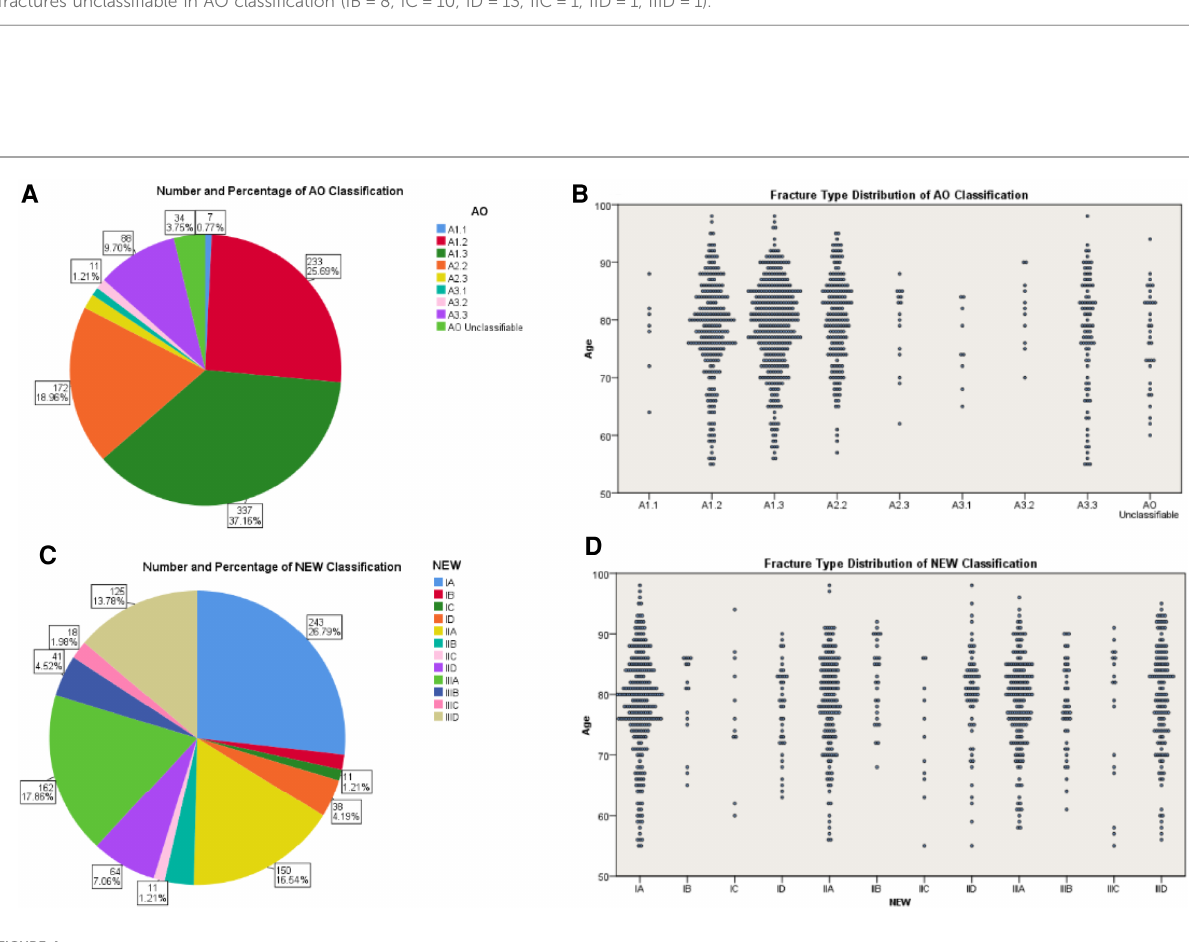
FIGURE 4 Percentages and distribution of fracture types. ( A ) Number and percentage of the fractures within the study population according to AO classi fi cation. ( B ) AO subgroups distribution of fractures in different age groups. ( C ) Number and percentage of the fractures within the study population according to new classi fi cation. ( D ) Fracture distribution in different age groups according to new classi fi